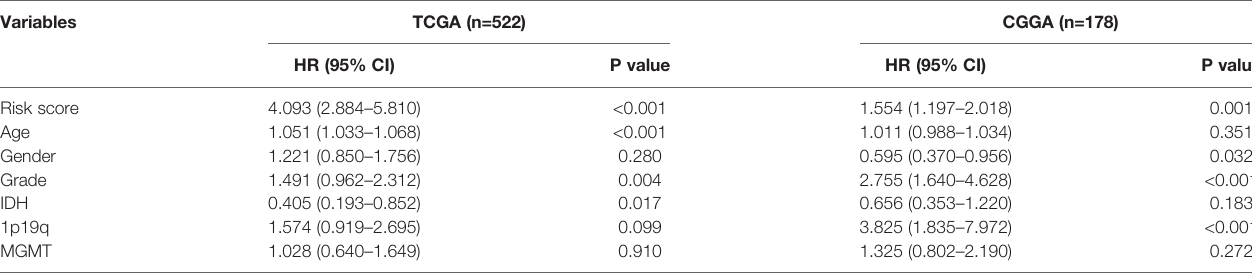
TABLE 2 | Multivariate analysis of risk signature in the training and validation cohorts.